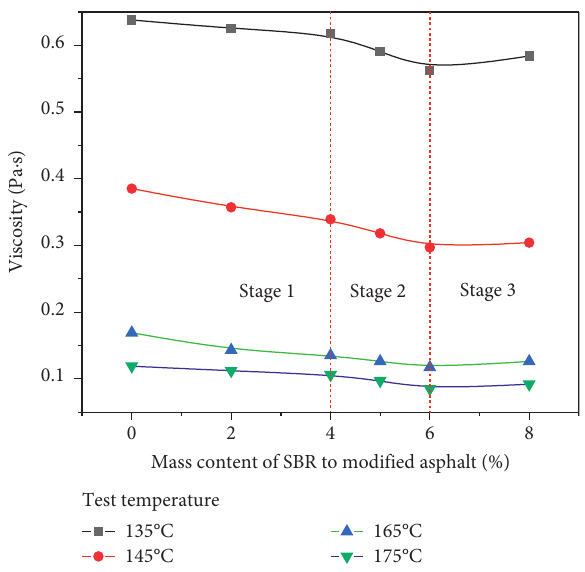
Figure 4: Variation patterns of brookfield viscosity with SBR contents.